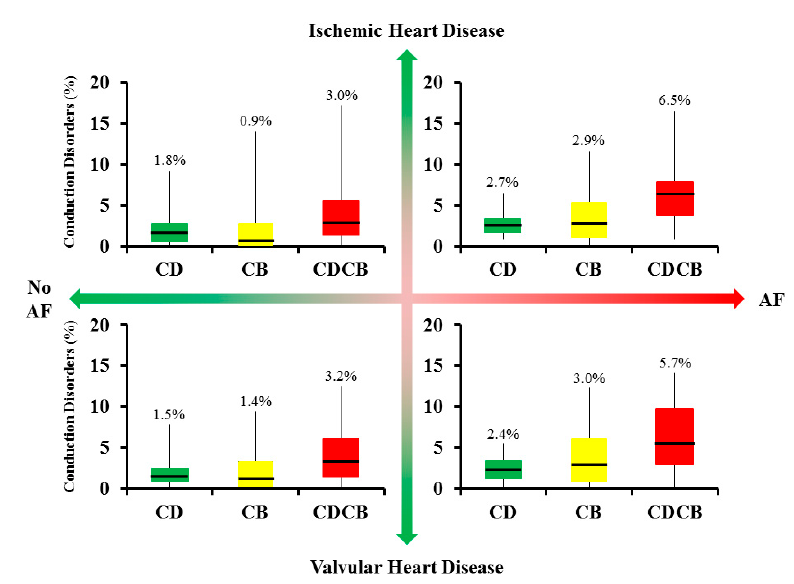
Figure 4. Relation between underlying heart disease, atrial fibrillation and conduction disorders Differences in the amount of conduction delay (green), block (yellow) and combined (red) between patients with ischemic heart disease ( upper panels ) and valvular heart disease ( lower panels ). In addition, difference in conduction disorders are shown between patients without atrial fibrillation ( left panels ) and with a history of atrial fibrillation ( right panels ). AF = atrial fibrillation; CB = conduction block; CD = conduction delay; CDCB = sum of conduction delay and block.